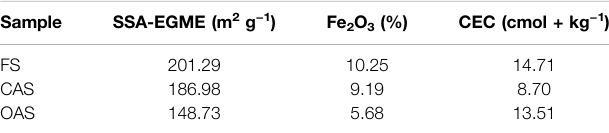
TABLE 4 | Surface properties of the clay fraction ( < 2 μ m). Sample